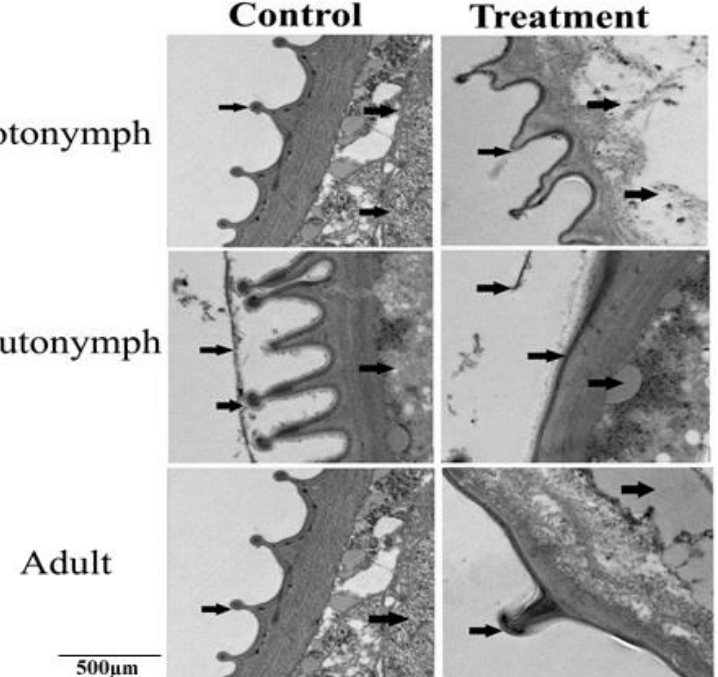
Figure 12. Transmission electron microscopic (TEM) analysis of the body wall denticles and tracheal taenidia at different developmental stages of P. citri treated with the target gene dsRN- PcCHS1 and control gene dsRNA- egfp . Arrows indicate the disturbance of chitin and ecdysial droplets, exhibiting a separation from the apical plasma membrane. Scale bar 500 µm.